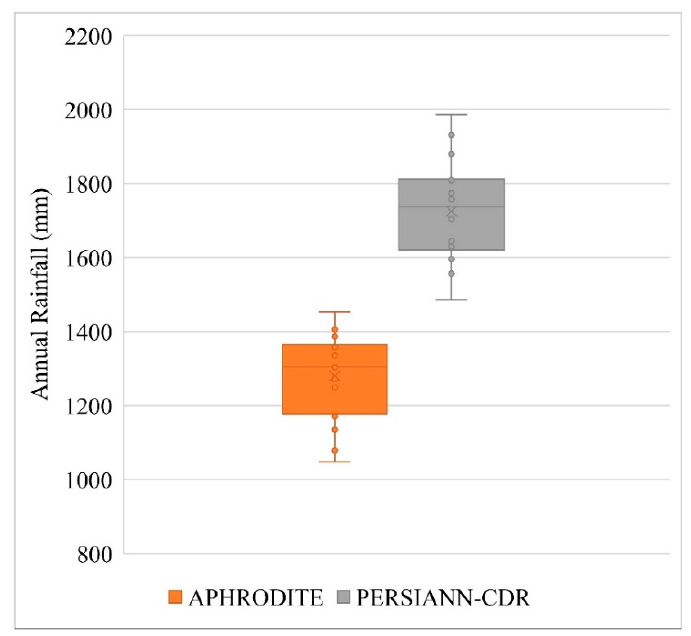
Figure 4. Box plot of the mean annual rainfall over the Mekong River basin from 1998 to 2015.